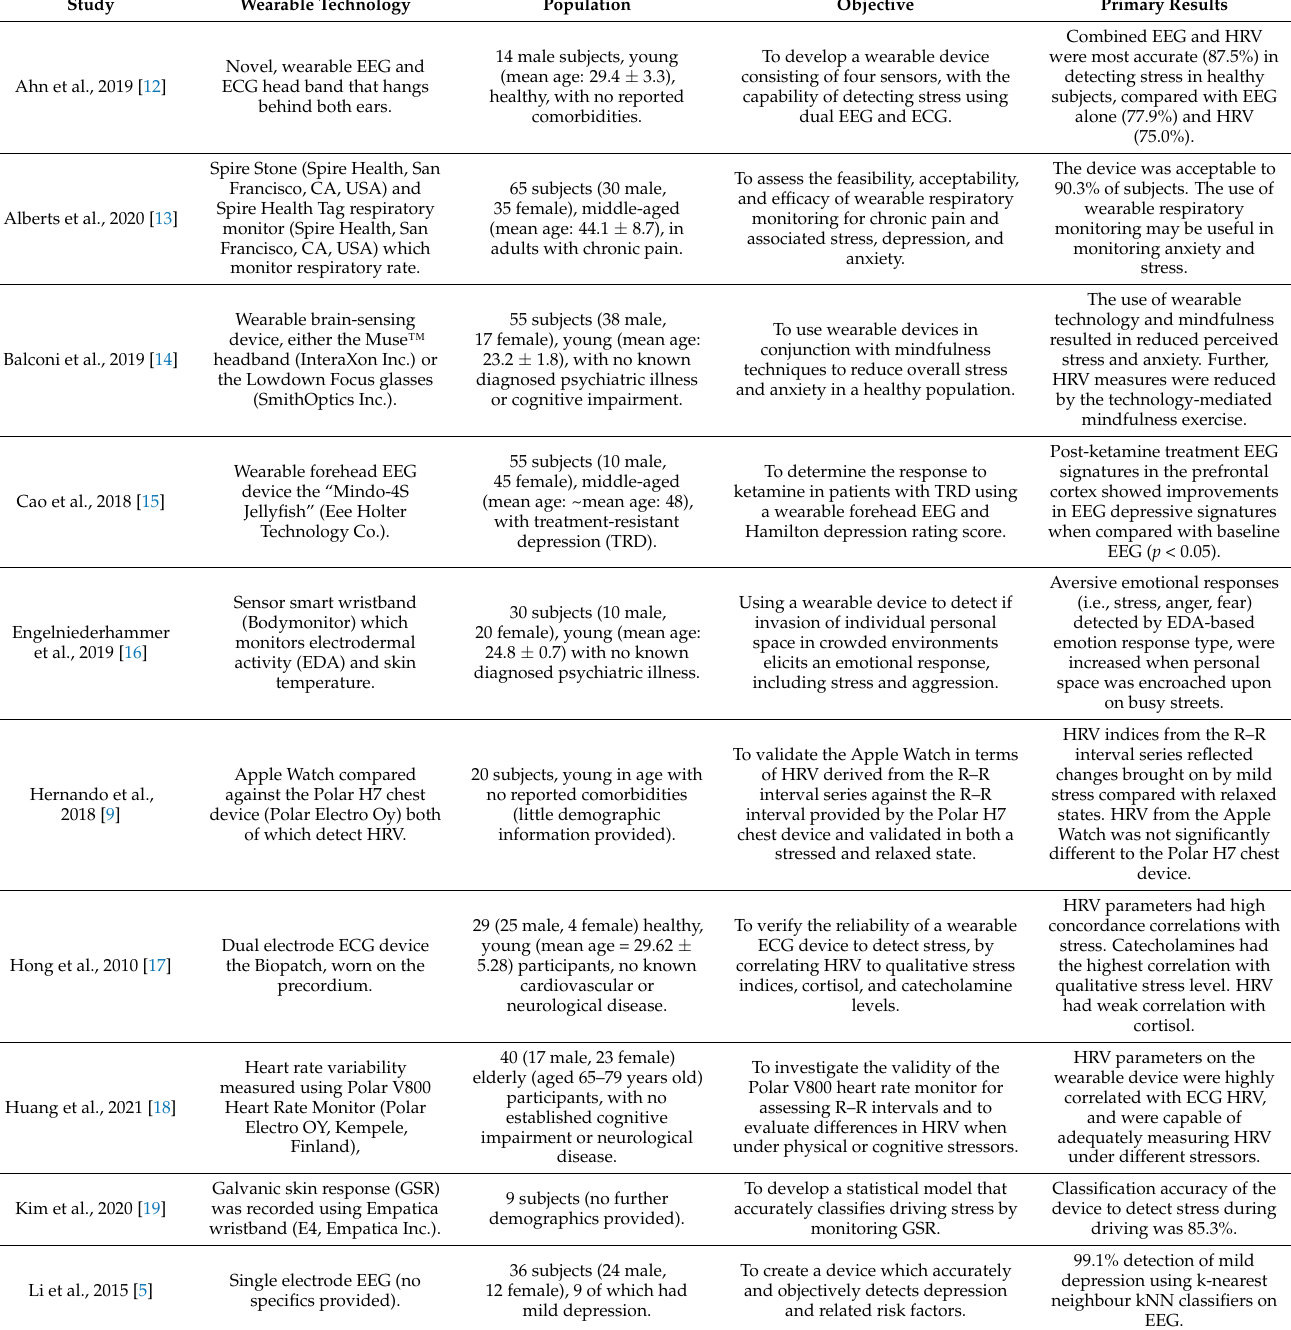
Table 5. Summary table of included research articles which utilise wearable technologies to detect stress, anxiety, and